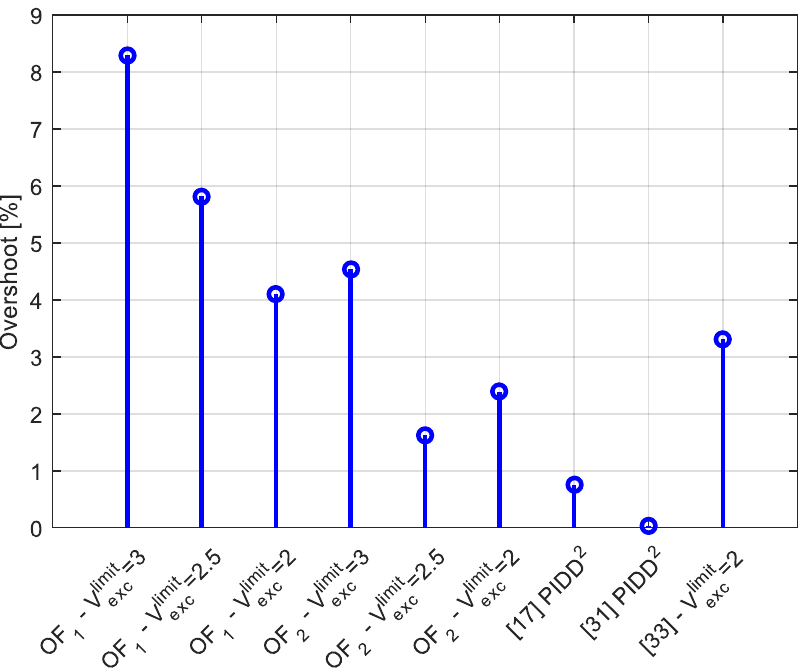
Figure 13. Comparison of the results in terms of the overshoot obtained using different methods.